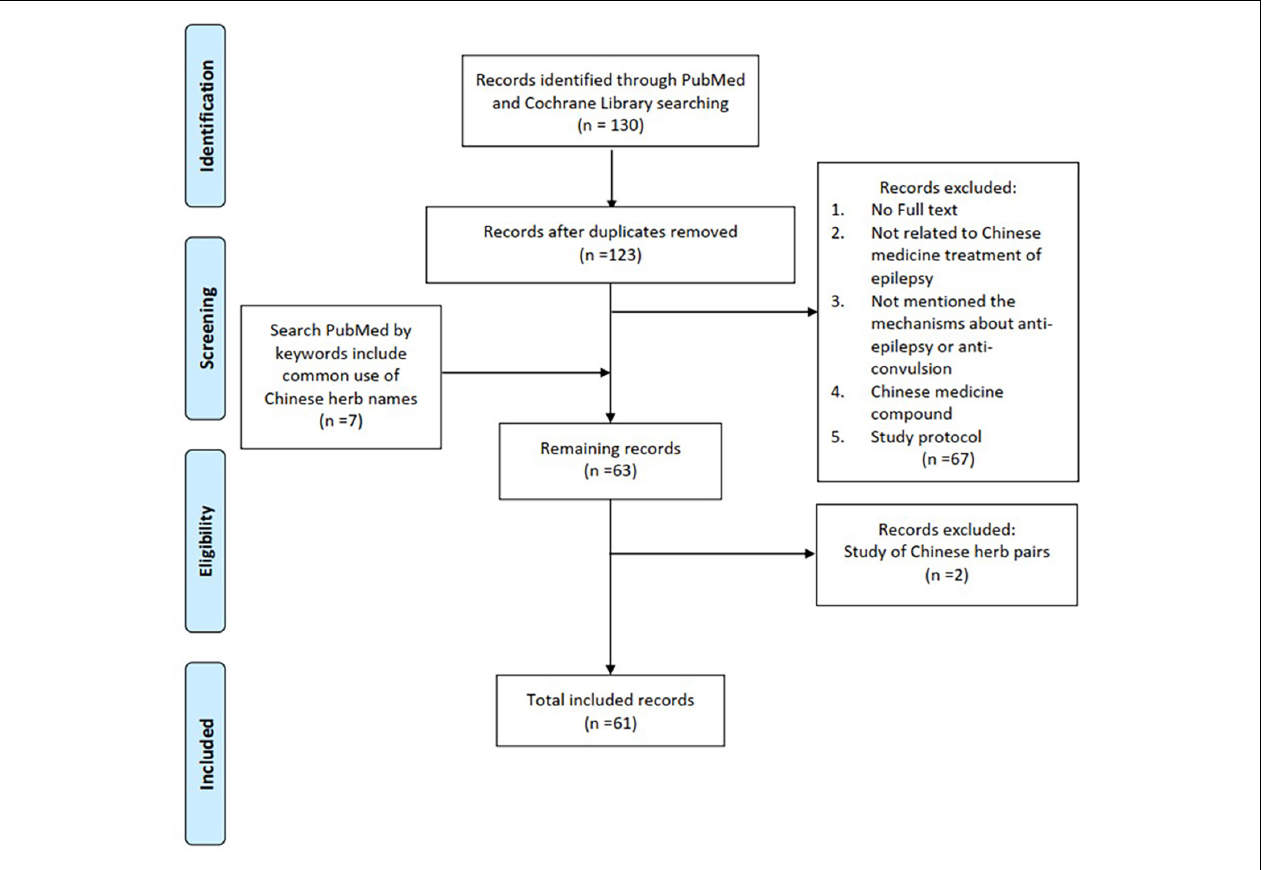
FIGURE 1 | Flow diagram of the literature search